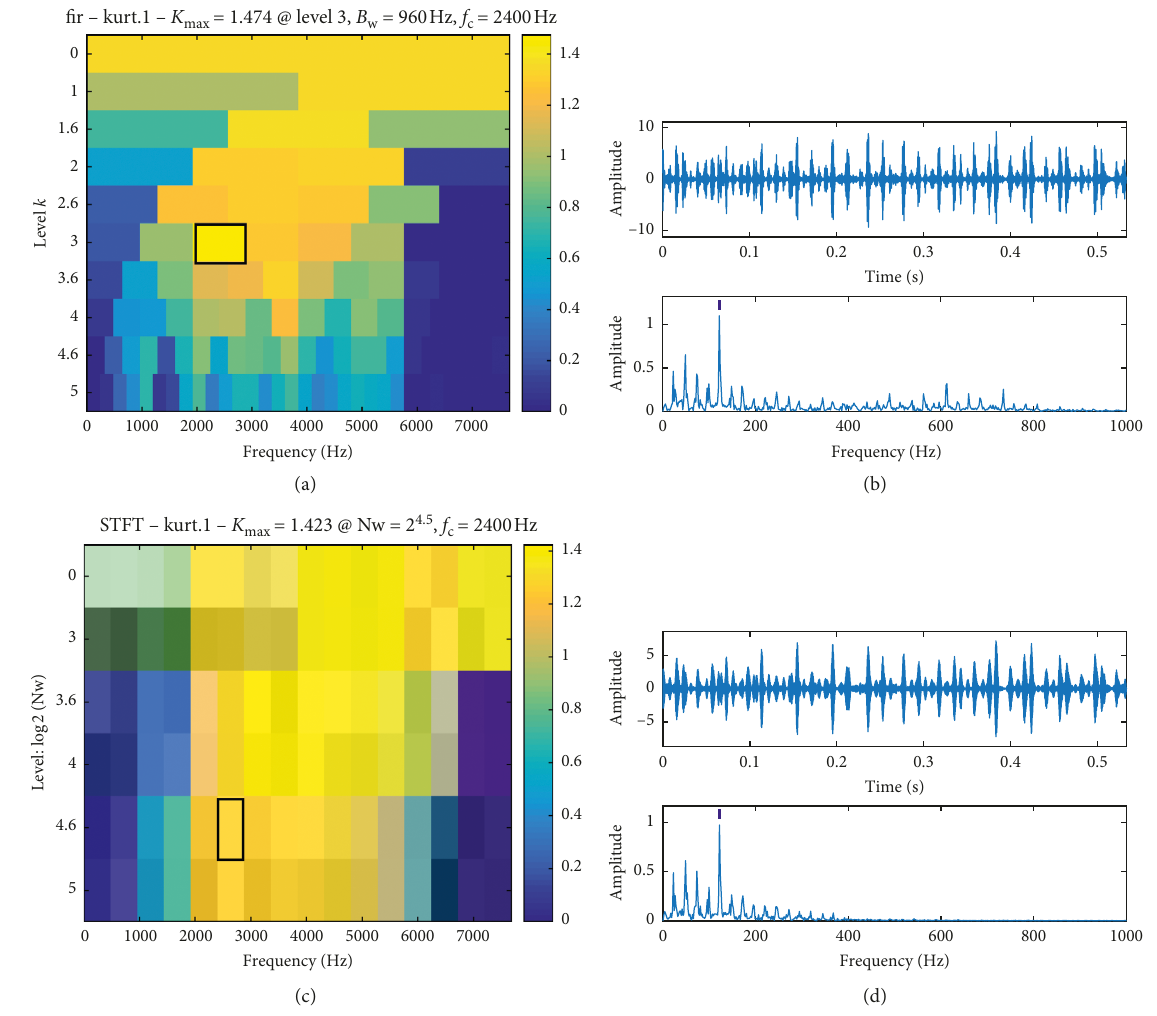
Figure 21: (a) Fast kurtogram based on FIR; (b) signal component and its envelope sequence; (c) fast kurtogram based on STFT; (d) signal component and its envelope